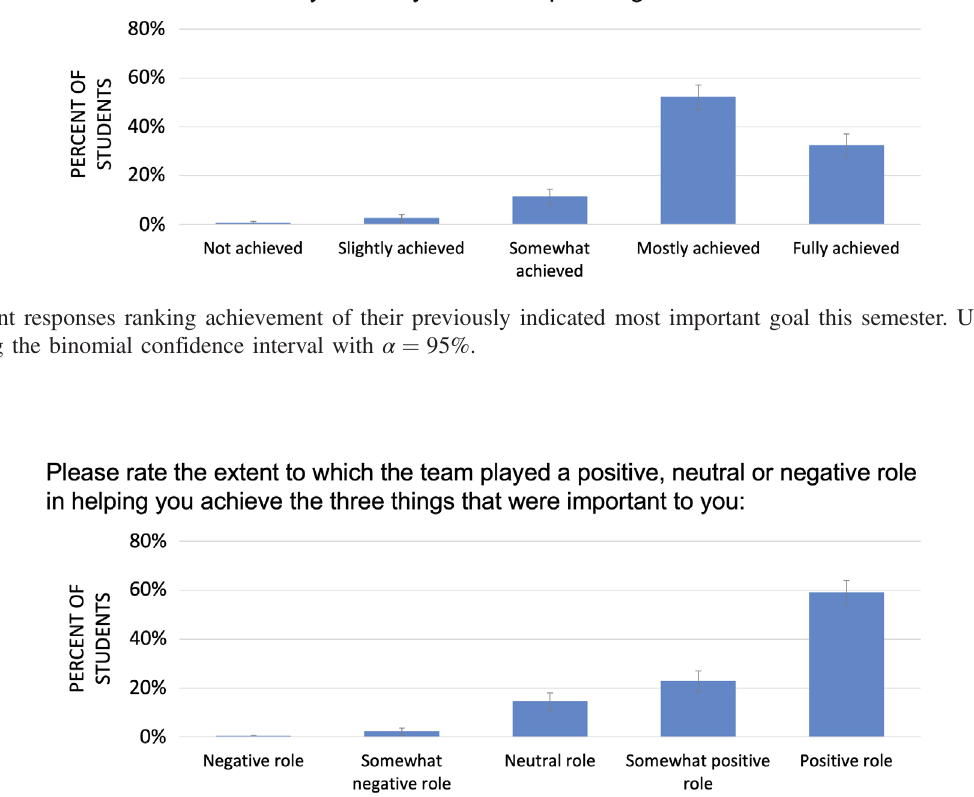
FIG. 7. Student responses ranking the role that the team played in achieving their indicated most important goal. Uncertainties are calculated using the binomial confidence interval with α ¼ 95% .